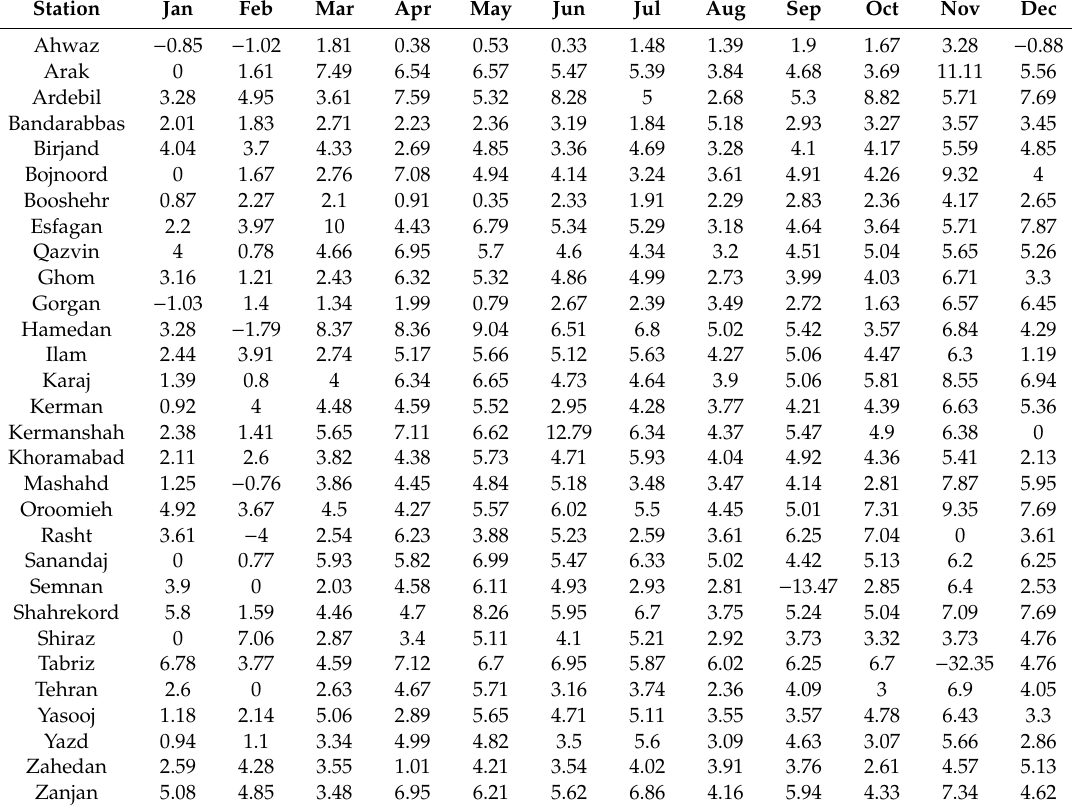
Table 6. Change percentages of the ET 0 predicted for the period from 2046 to 2079 under the B1 scenario.